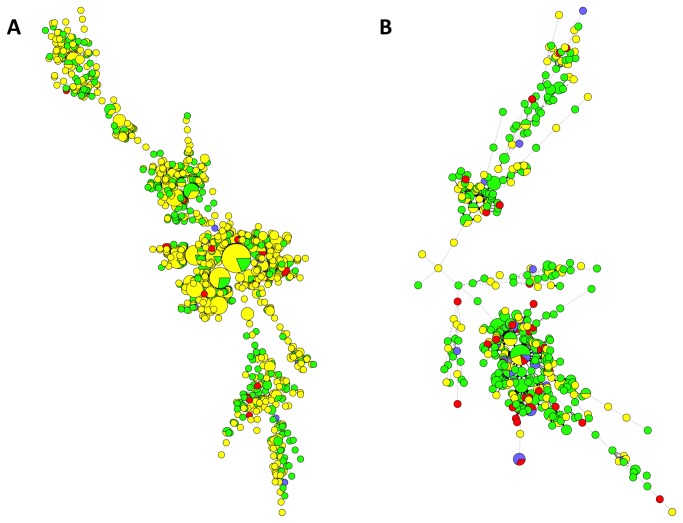
Minimum spanning trees of MTC isolates typed via both spoligotyping and MIRU-VNTR, categorized according to patient resident status and presence of multidrug-resistance (MDR) (yellow = resident with non-MDR-TB, green = non-resident with non-MDR-TB, blue = resident with MDR-TB, red = non-resident with MDR-TB).Each circle represents a genotype and the sizes of the circles are proportionate to the number of members in each group. The distance between circles represents how closely related the different genotypes are to each other. 1A) MTC isolates from the earlier 2006-2007 phase. 1B) MTC isolates from the later 2008-2012 phase.